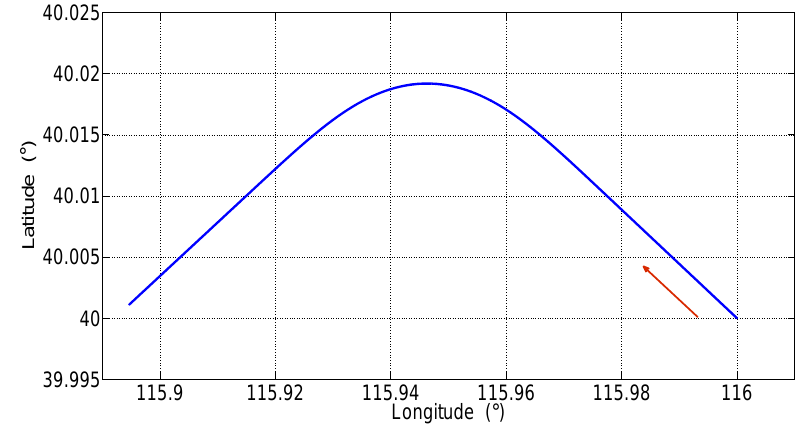
Figure 4. Trajectory of the simulation.